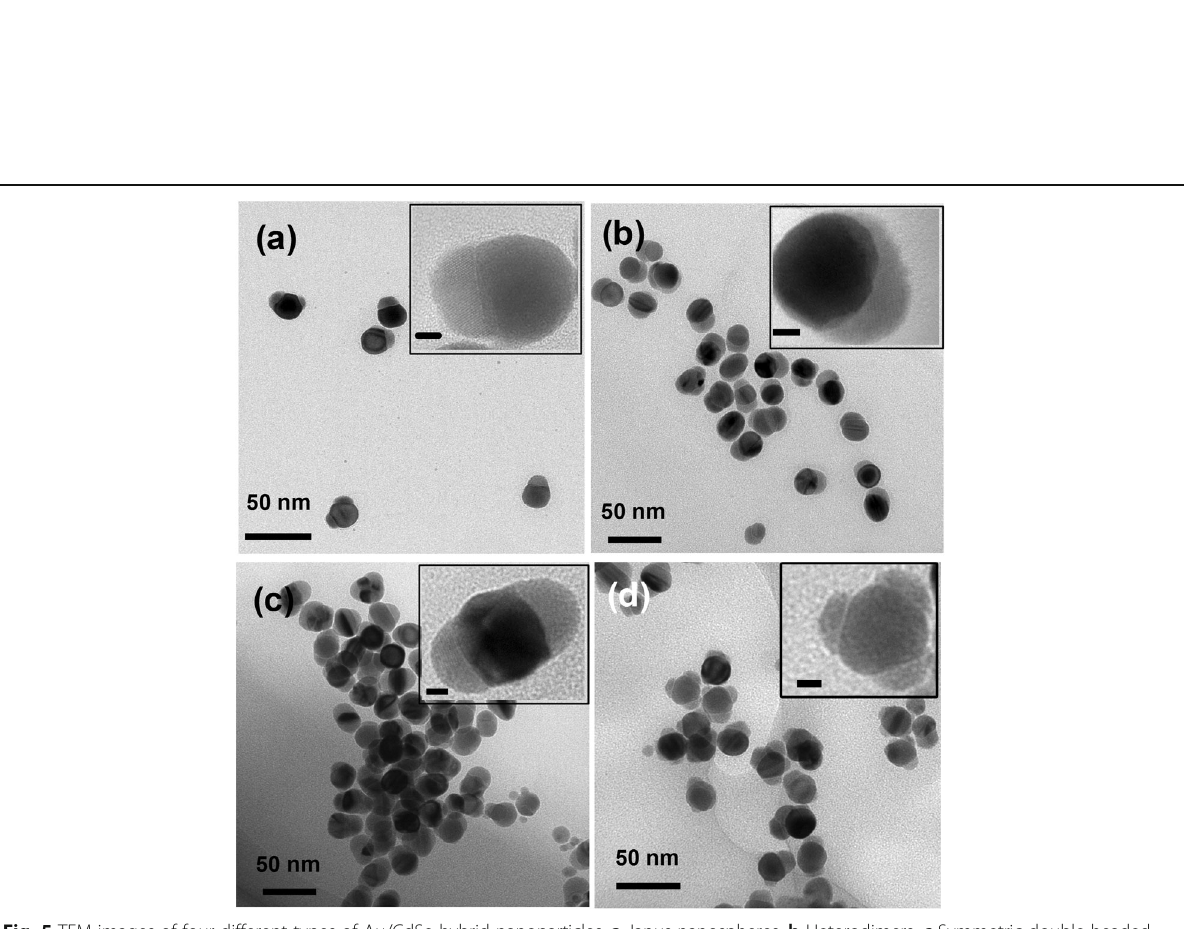
Fig. 5 TEM images of four different types of Au/CdSe hybrid nanoparticles. a Janus nanospheres. b Heterodimers. c Symmetric double-headed nanoparticles. d Multi-headed nanoparticles. The hybrids are synthesized through manipulating the pH value of Ag deposition (2.5, 4.5, 7.2, 8.1, respectively) with the same amount of Cd(NO 3 ) 2 (0.05 mL and 0.1 M). The scale bars in the insets are 5